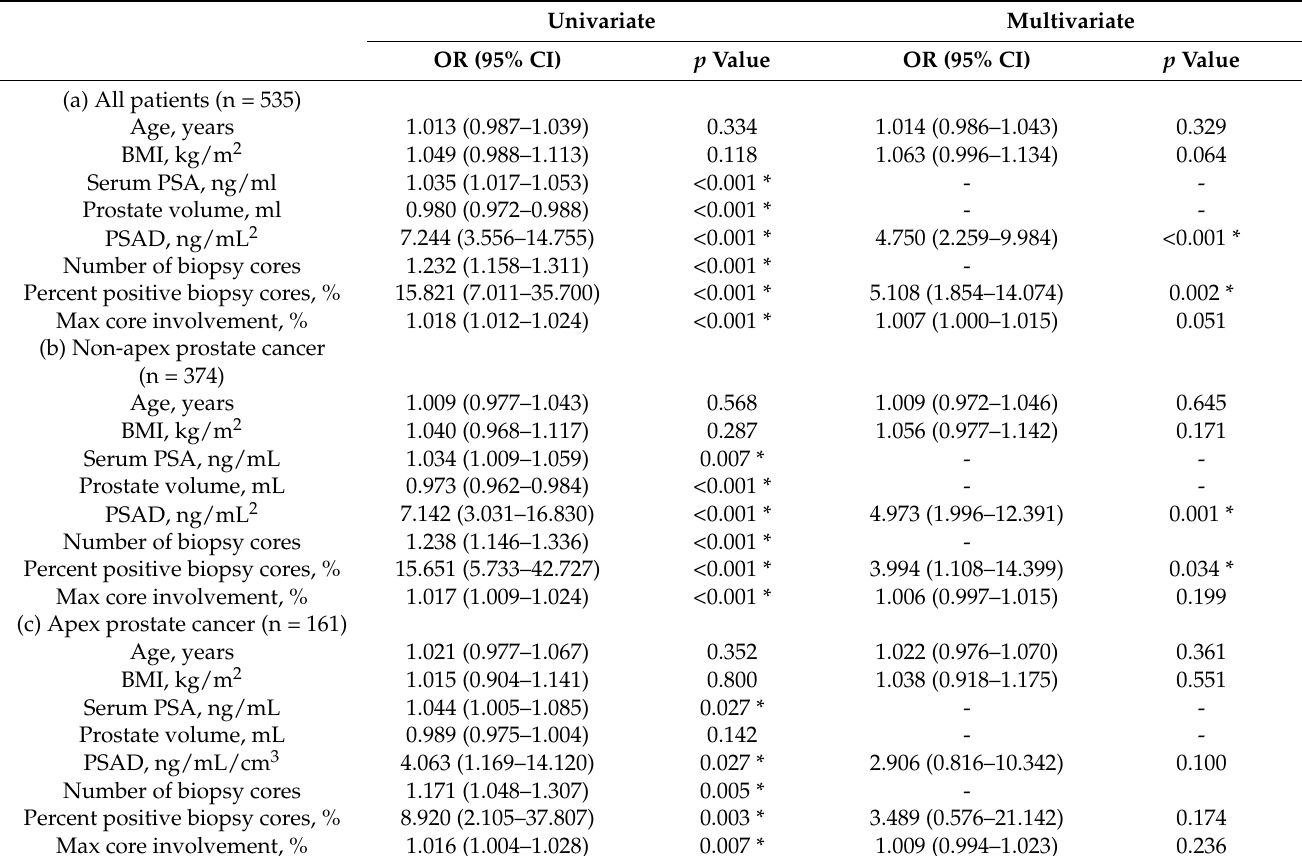
Table 3. Univariate and multivariate analysis for predicting pathological upstaging. Univariate Multivariate OR (95% CI) p Value OR (95%